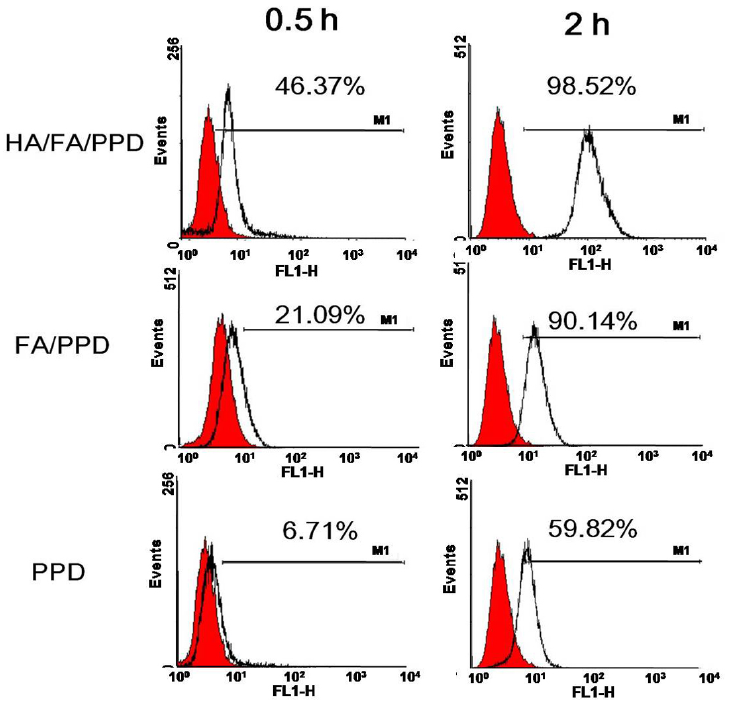
Figure 8. In vitro targeting cellular uptake of Rho-PTX (Rhodamine-PTX) labeled HA/FA/PPD on B16 cells ( n = 3). HA/FA/PPD incubated with B16 cells for 0.5 or 2 h, respectively, while FA/PPD and PPD were served as